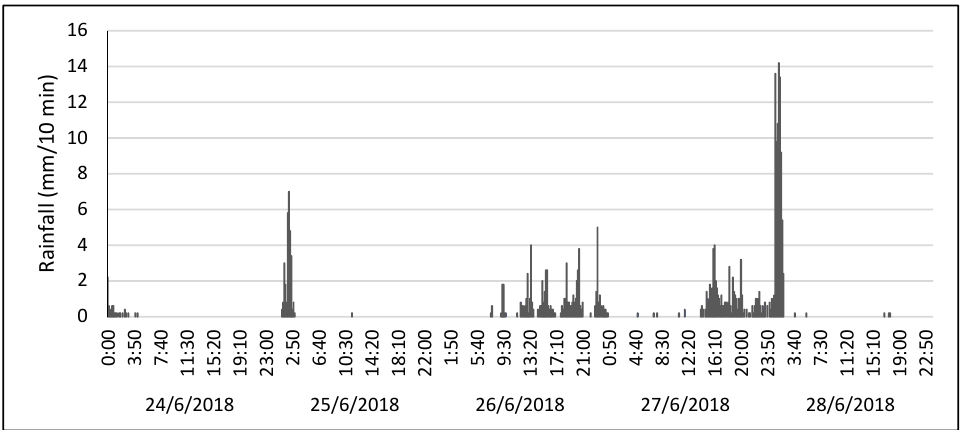
Figure 3. Rainfall intensity at Asprovalta observatory during the June 2018 flood event .